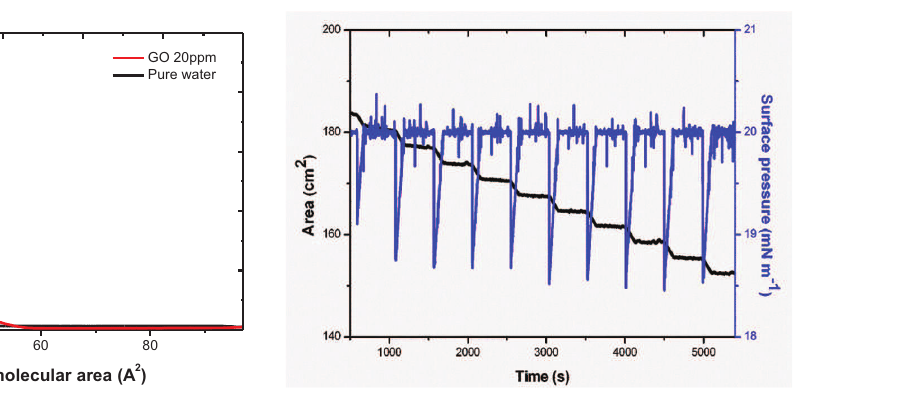
at the air-water surface, and the blue curve shows the surface pressure throughout (around 20mNm − 1 ) the deposition of a 10-layer ODA–GO–ODA–C 60 hybrid film.